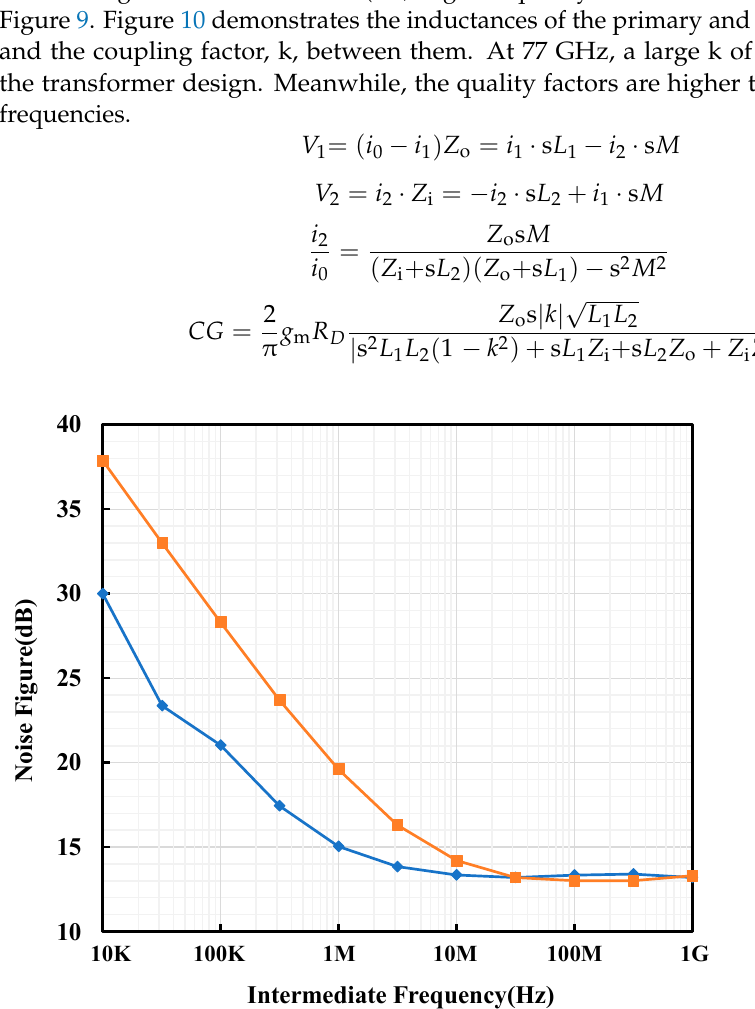
Figure 7. The simulated noise figure of the mixer.